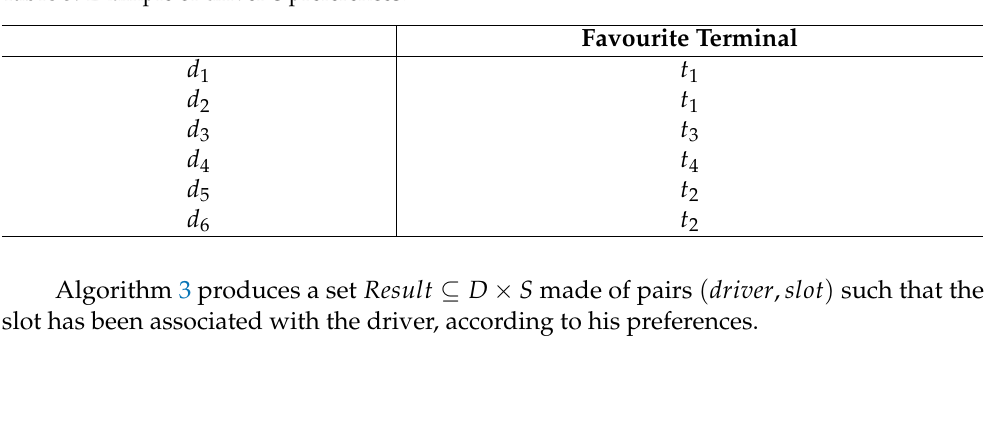
Table 5. Example of driver’s